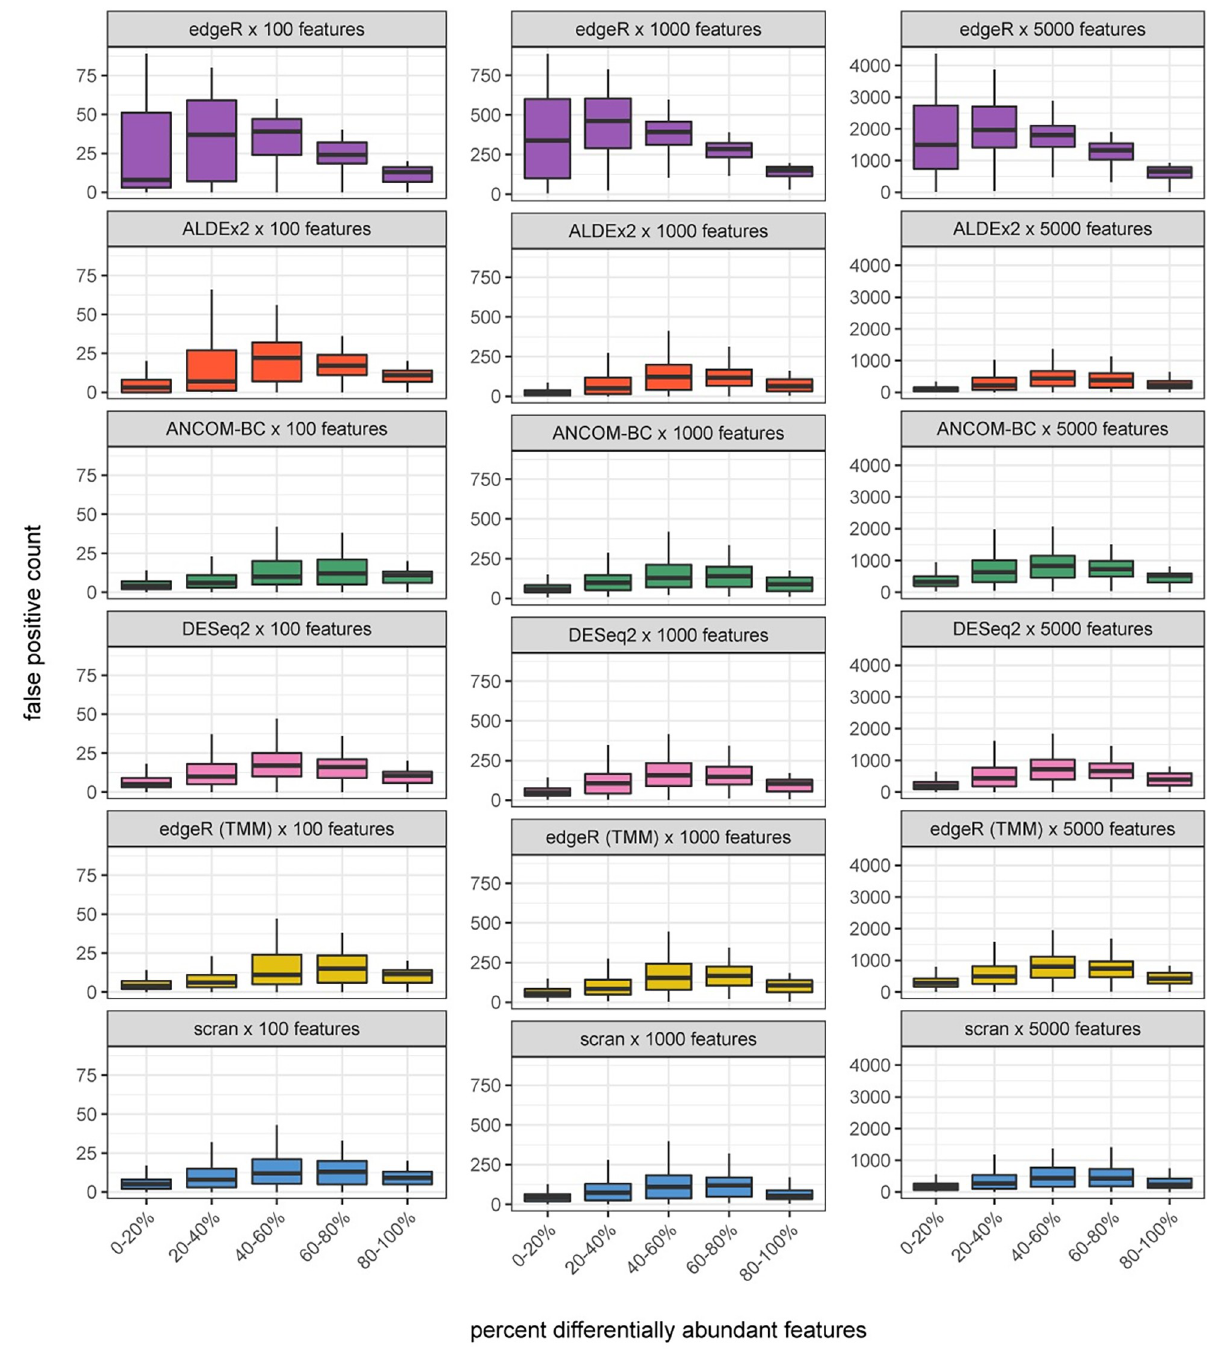
Fig 2. False positive counts as a function of percent differentially abundant features in simulation. Counts of false positives as a function of the percent of simulated differentially abundant features for six methods. edgeR with no heuristic rescaling is shown at top. Columns segregate simulations with increasing numbers of features. All rescaling methods have higher overall accuracy than edgeR without rescaling. Counts of false positives tend to be highest where a majority of features are differentially abundant.